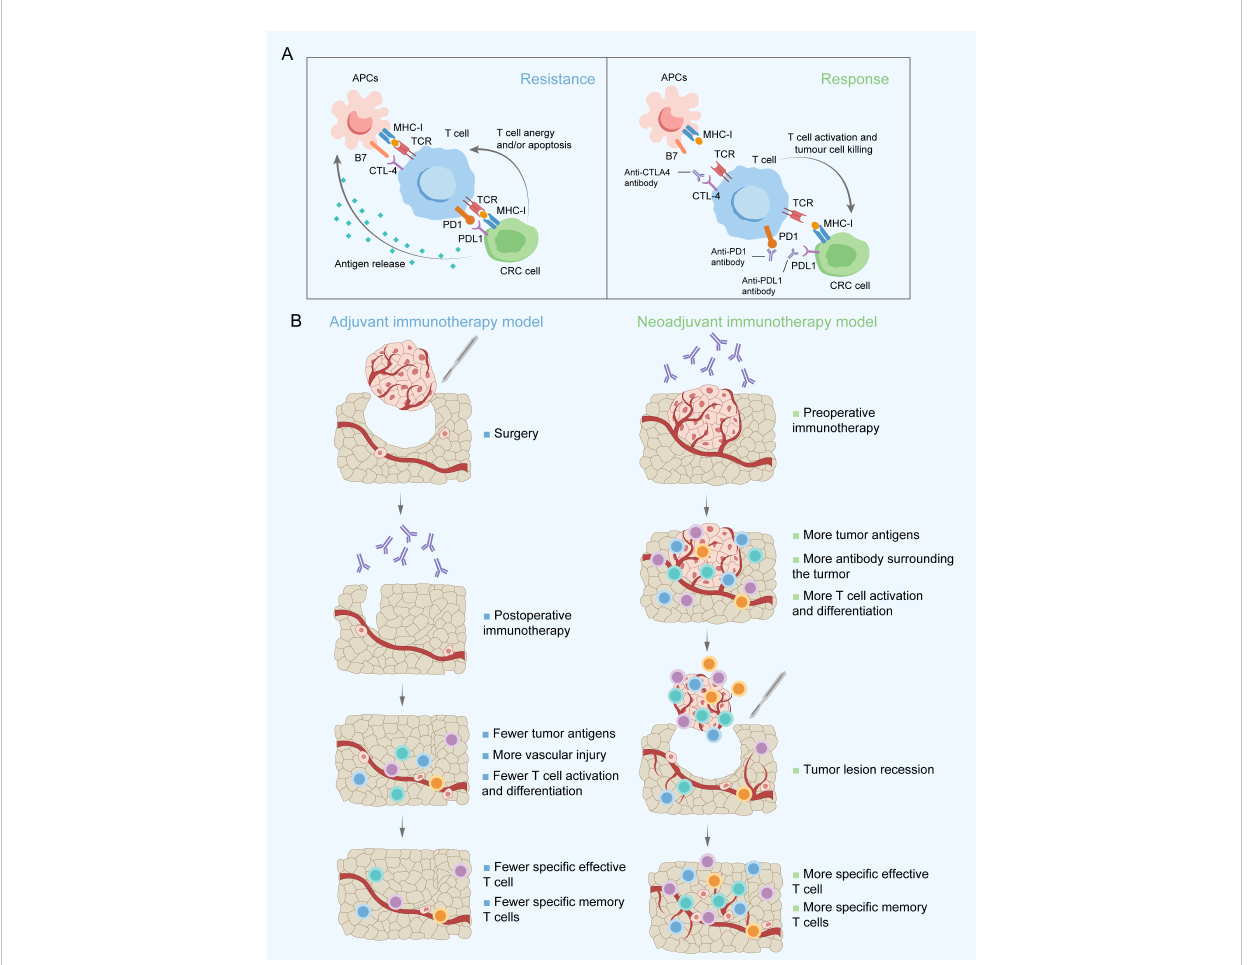
FIGURE 1 Main targets of immune checkpoint inhibitors applied in the clinic (A) and proposed rationale for immunotherapy administered postoperatively and preoperatively (B) . APCs, Antigen-presenting cells; CRC, Colorectal cancer; CTLA-4, Cytotoxic T-lymphocyte-associated antigen-4; MHC-I, Major histocompatibility complex class I; PD-1, Programmed death-1; PD-L1, Programmed death-ligand 1; TCR, T-cell